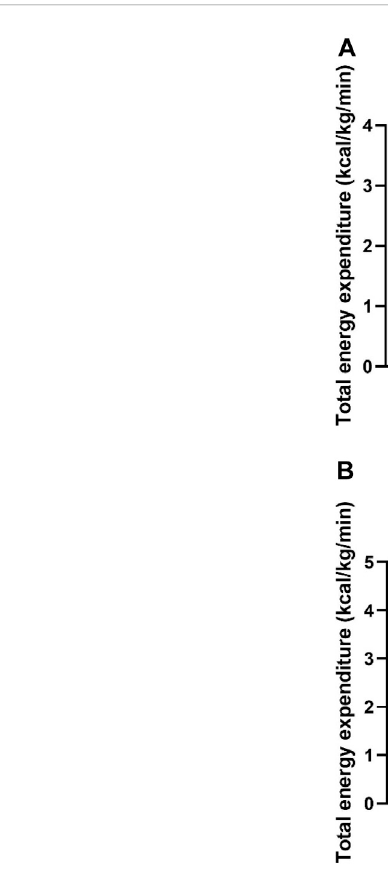
FIGURE 3 Changes in whole-body energy expenditure in participants between pre- and post-administration of interventions in a 120 min period. (A) day 1 and (B) day 7. Grey bar, placebo capsule; blue bar, caffeine capsule; red bar, C. annuum fruit powder capsule. Data is expressed as mean ± SD, n = 8 per intervention, *represents interaction effect (** p < .001). Data values were analysed using repeated measures 2-way analysis of variance (ANOVA; pre × post). Each ANOVA assessed differences between treatments (caffeine, C. annuum , and placebo) and time points (pre vs. post